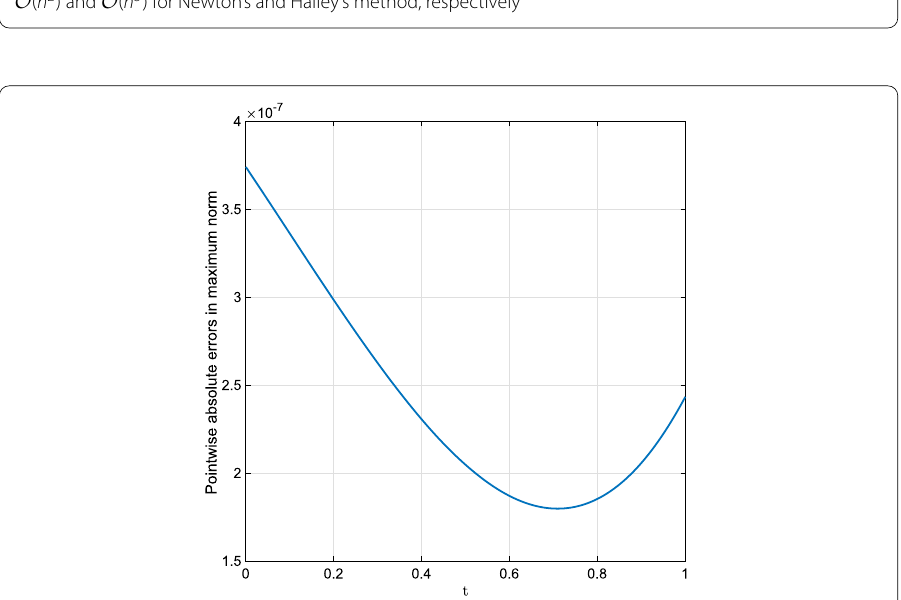
Figure 4 Pointwise absolute errors in maximum norm obtained by the proposed shooting technique with Newton’s method of Example 4.3 versus the time step h when ( α 1 , α 2 ) = (0.4,1.7), s 0 = 0.2, N = 320, m = 10